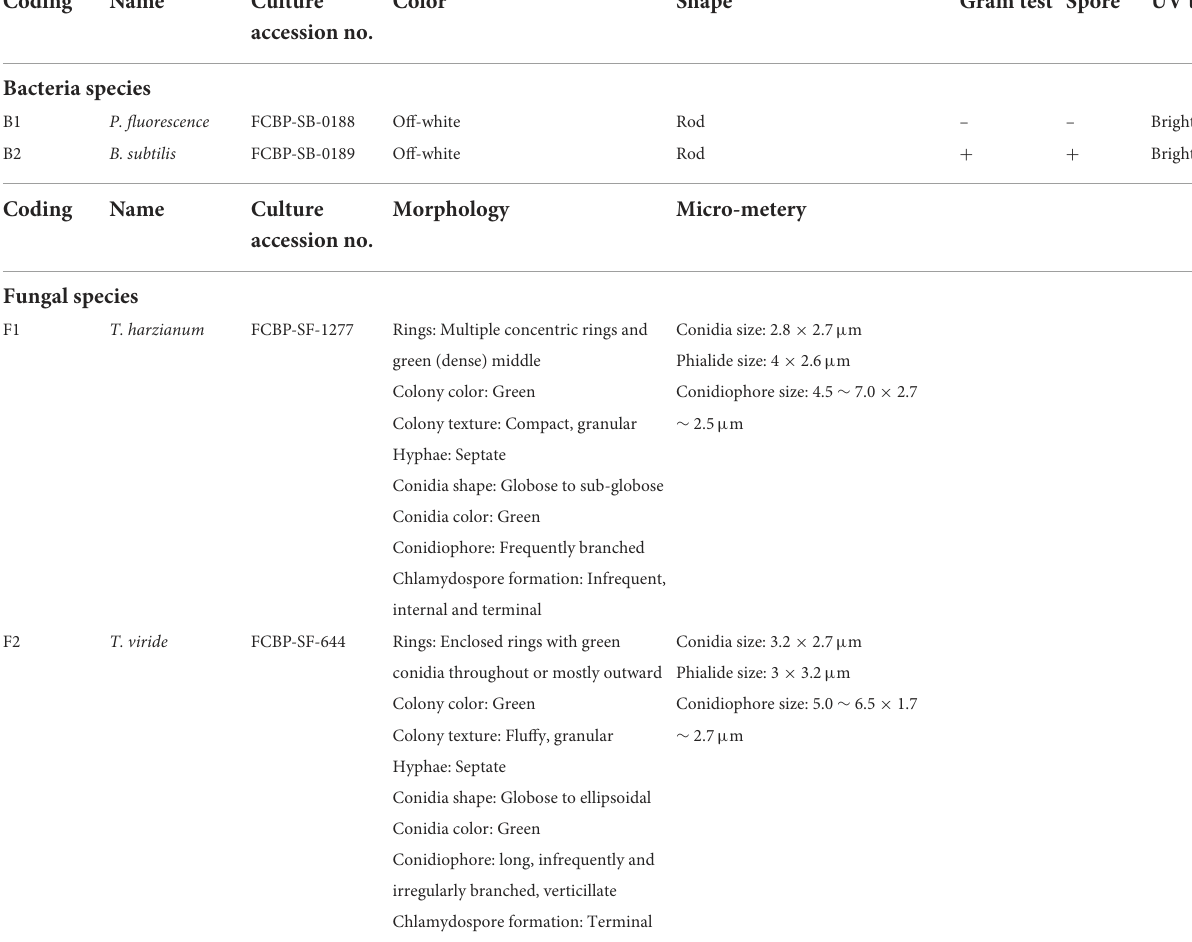
TABLE 2 Selected microbial species